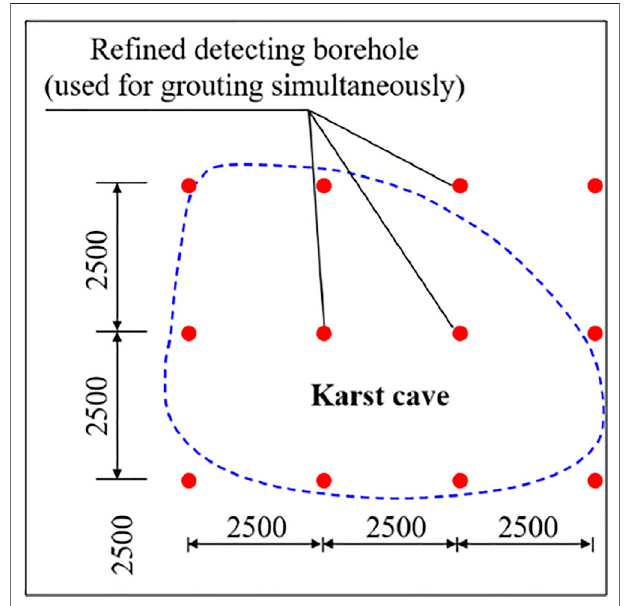
FIGURE 10 | Layout of the re fi ned